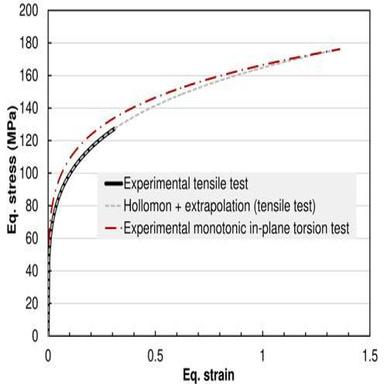
Tensile and monotonic in-plane torsion test flow curves.